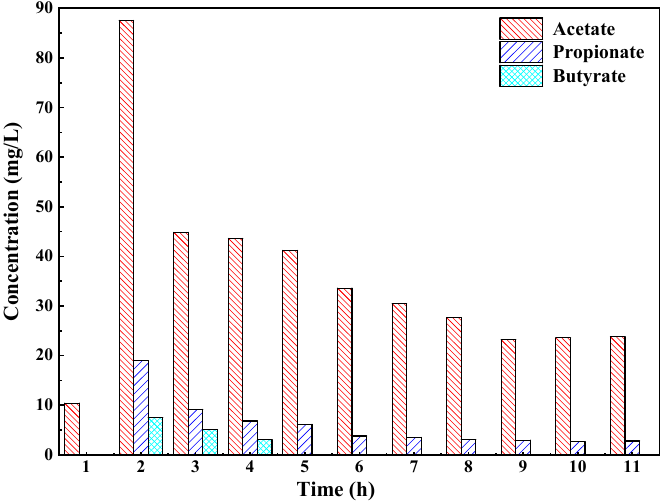
Figure 4. Cyclic concentration profiles of VFAs in one ASBR cycle.